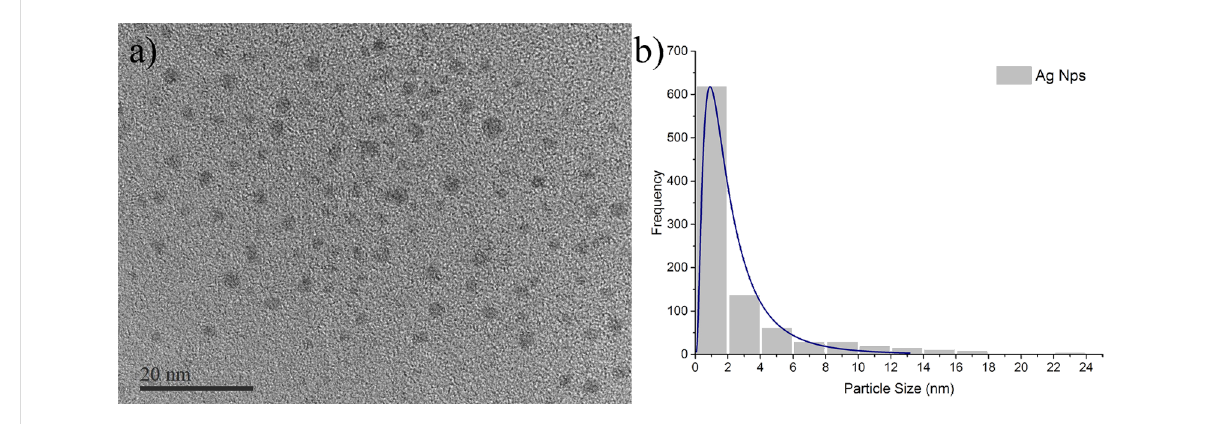
Figure 1: (a) TEM micrograph of AgNPs. (b) Log–normal size distribution graph shows the average AgNP size of approximately 1